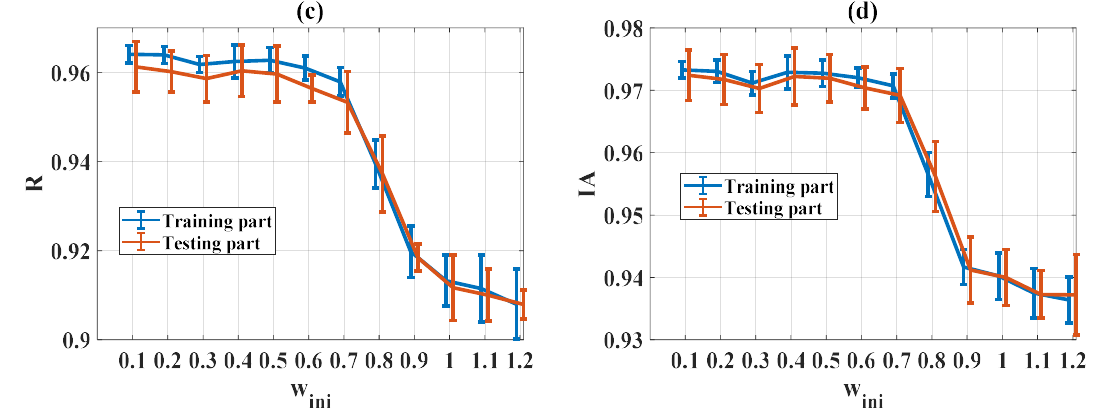
Figure 10. Evaluation of statistical criteria in the function of w ini : ( a ) RMSE, ( b ) MAE, ( c ) R, and ( d ) IA.